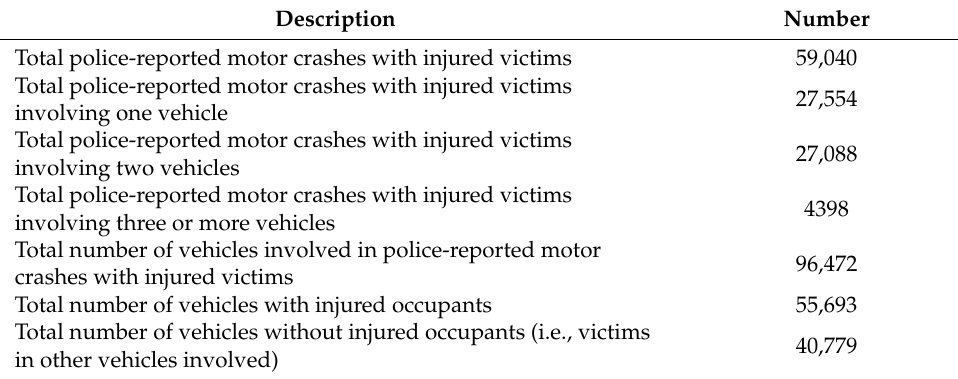
Table 1. Description of dataset of road crashes with complete records.